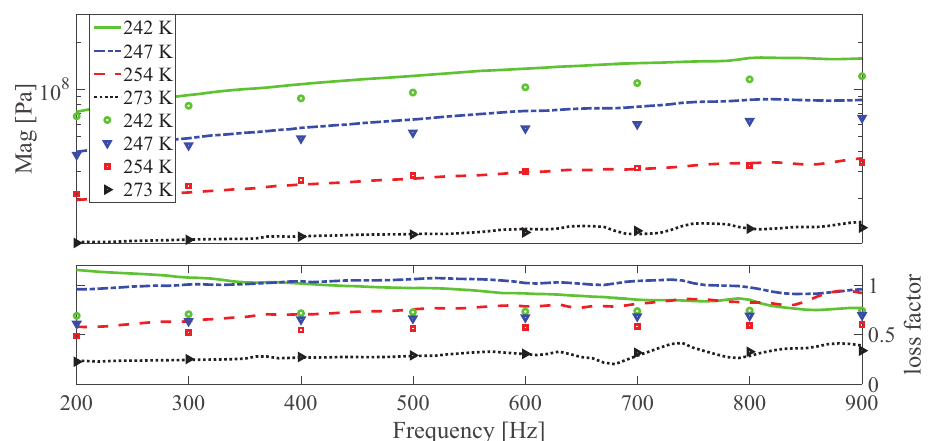
Figure 12. The magnitude and loss factor of the dynamic shear modulus versus frequency at 0.0015 strain amplitude and 0T magnetic field under different temperatures. Lines and symbols are the simulation and measurement results, respectively.